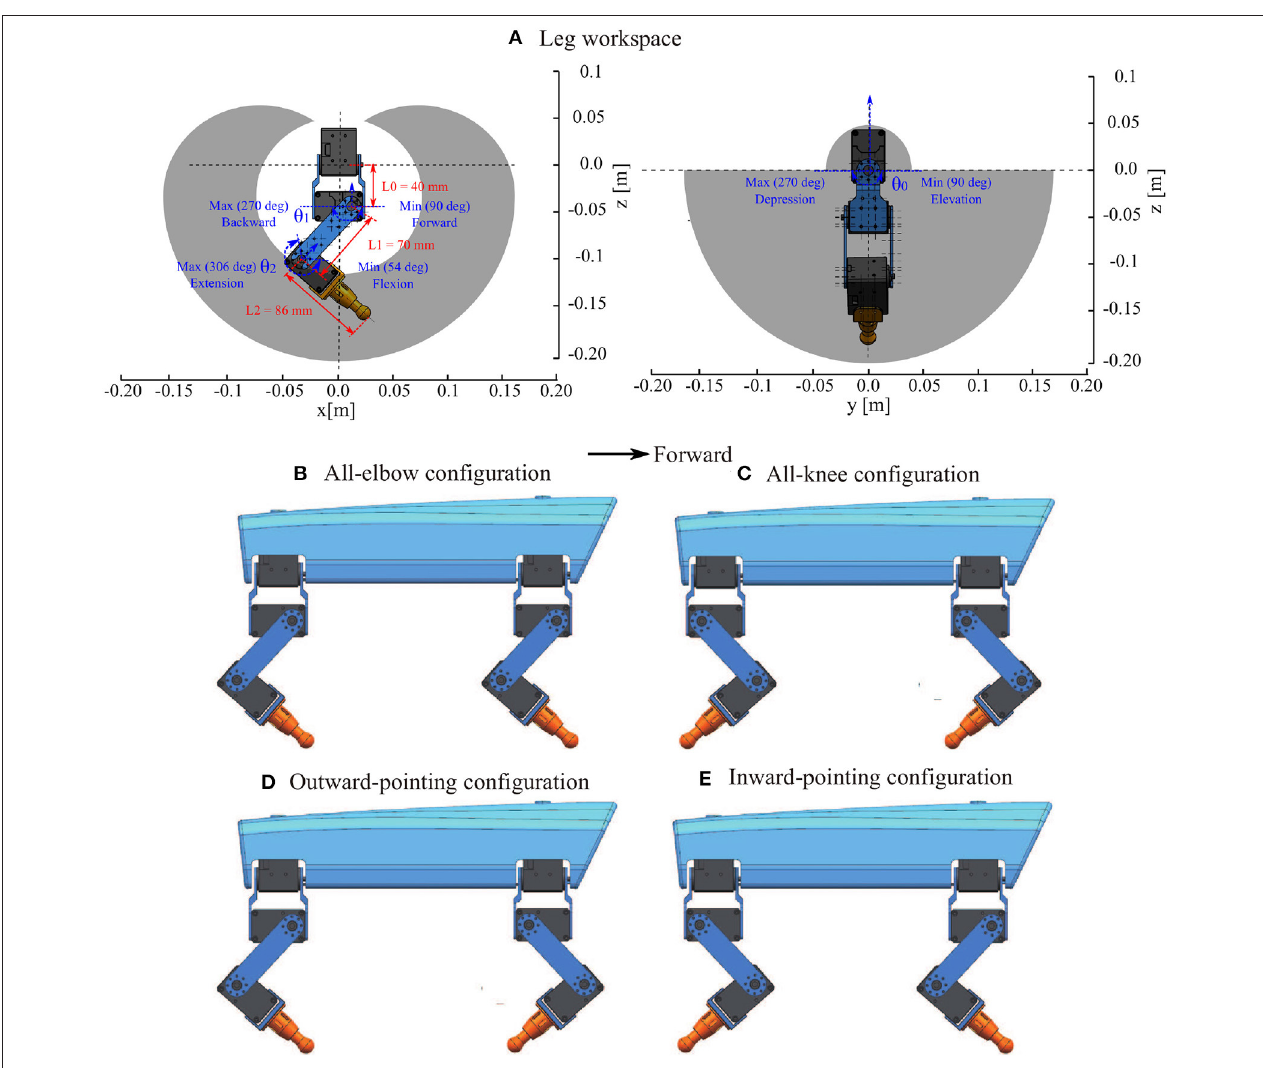
FIGURE 4 | Leg workspace and various configurations. (A) The leg has a large and symmetric workspace that enables the robot to exhibit four different configurations or orientations, as indicated in (B–E) . (B) All-elbow configuration. (C) All-knee configuration. (D) Outward-pointing configuration. (E) Inward-pointing configuration.